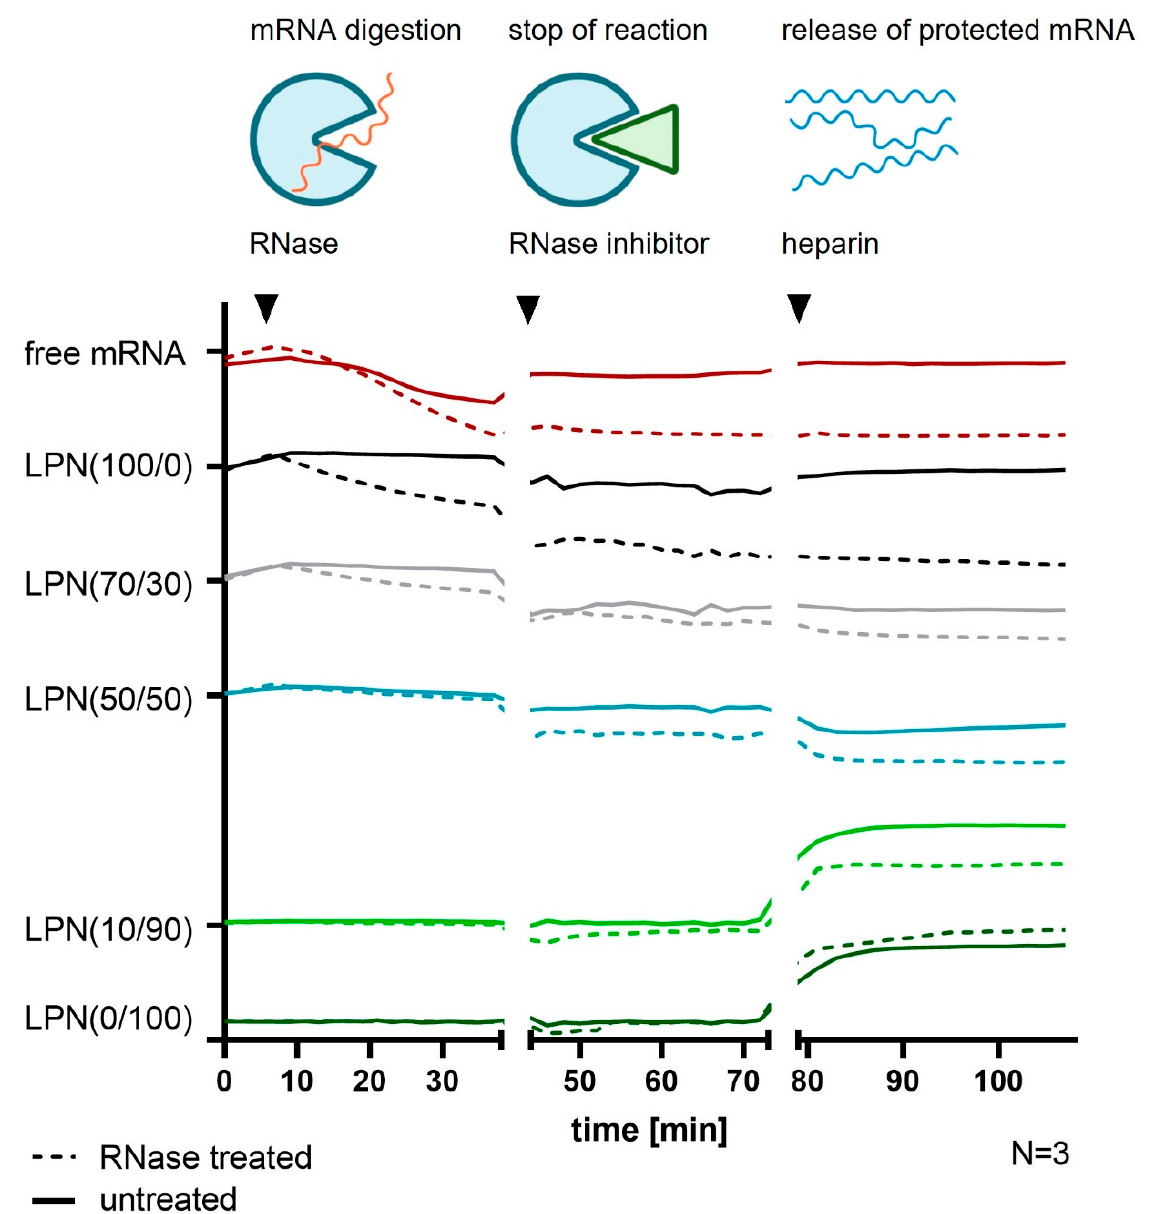
Figure 5. RiboGreen ® assay for RNase A degradation. mRNA loaded LPNs were monitored for the fluorescence intensity of RiboGreen ® binding to accessible mRNA while sequentially exposed to RNase A and heparin. mRNA protection against RNase A is stronger with higher DOTMA percentage, while the mRNA release upon heparin addition shows less dependency on DOTMA. Solid lines represent untreated samples, dotted lines the RNase treated ones of the same kind. Colors represent the different LPN samples as named. Y-axis shows measured fluorescence intensities of RiboGreen ® in arbitrary units for each sample separately to display differences between the two treatment groups. Samples were added to one y-axis to enable comparison of curves. Hight of sample on y-axis is not connected to measured fluorescence